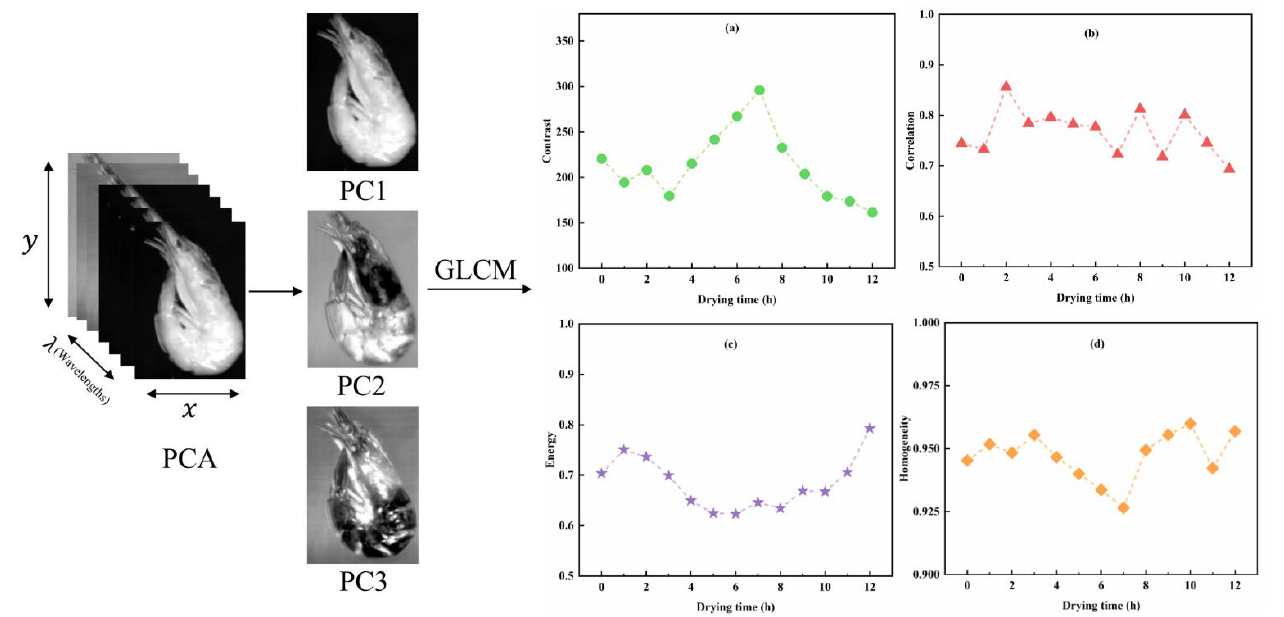
Figure 8. PCA process and texture features of shrimp samples, ( a – d ) stand for the change of contrast, correlation, energy, and homogeneity, respectively.